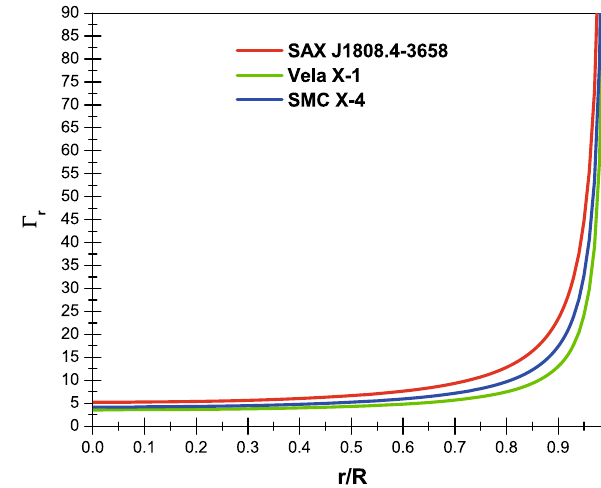
Fig. 17 TOV equation for the strange star candidate SMC X-4 versus the fractional radial coordinate for α = 0 . 3